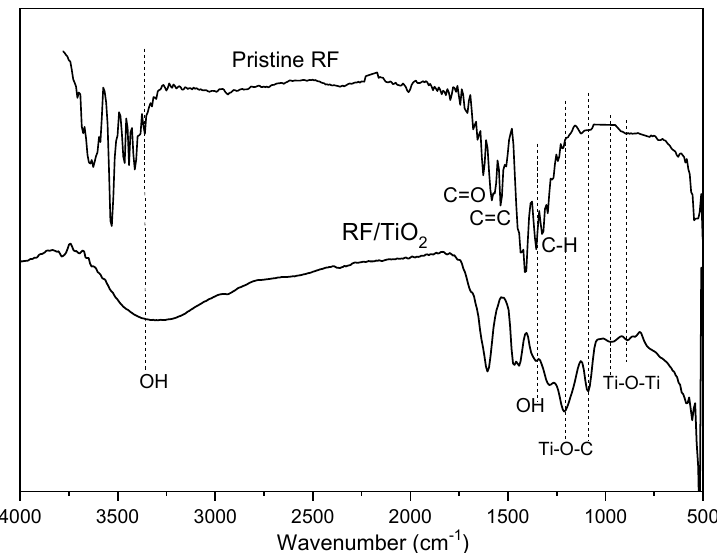
Figure 2. FTIR spectra of synthesised RF/TiO 2 gel compared to pristine RF gel.